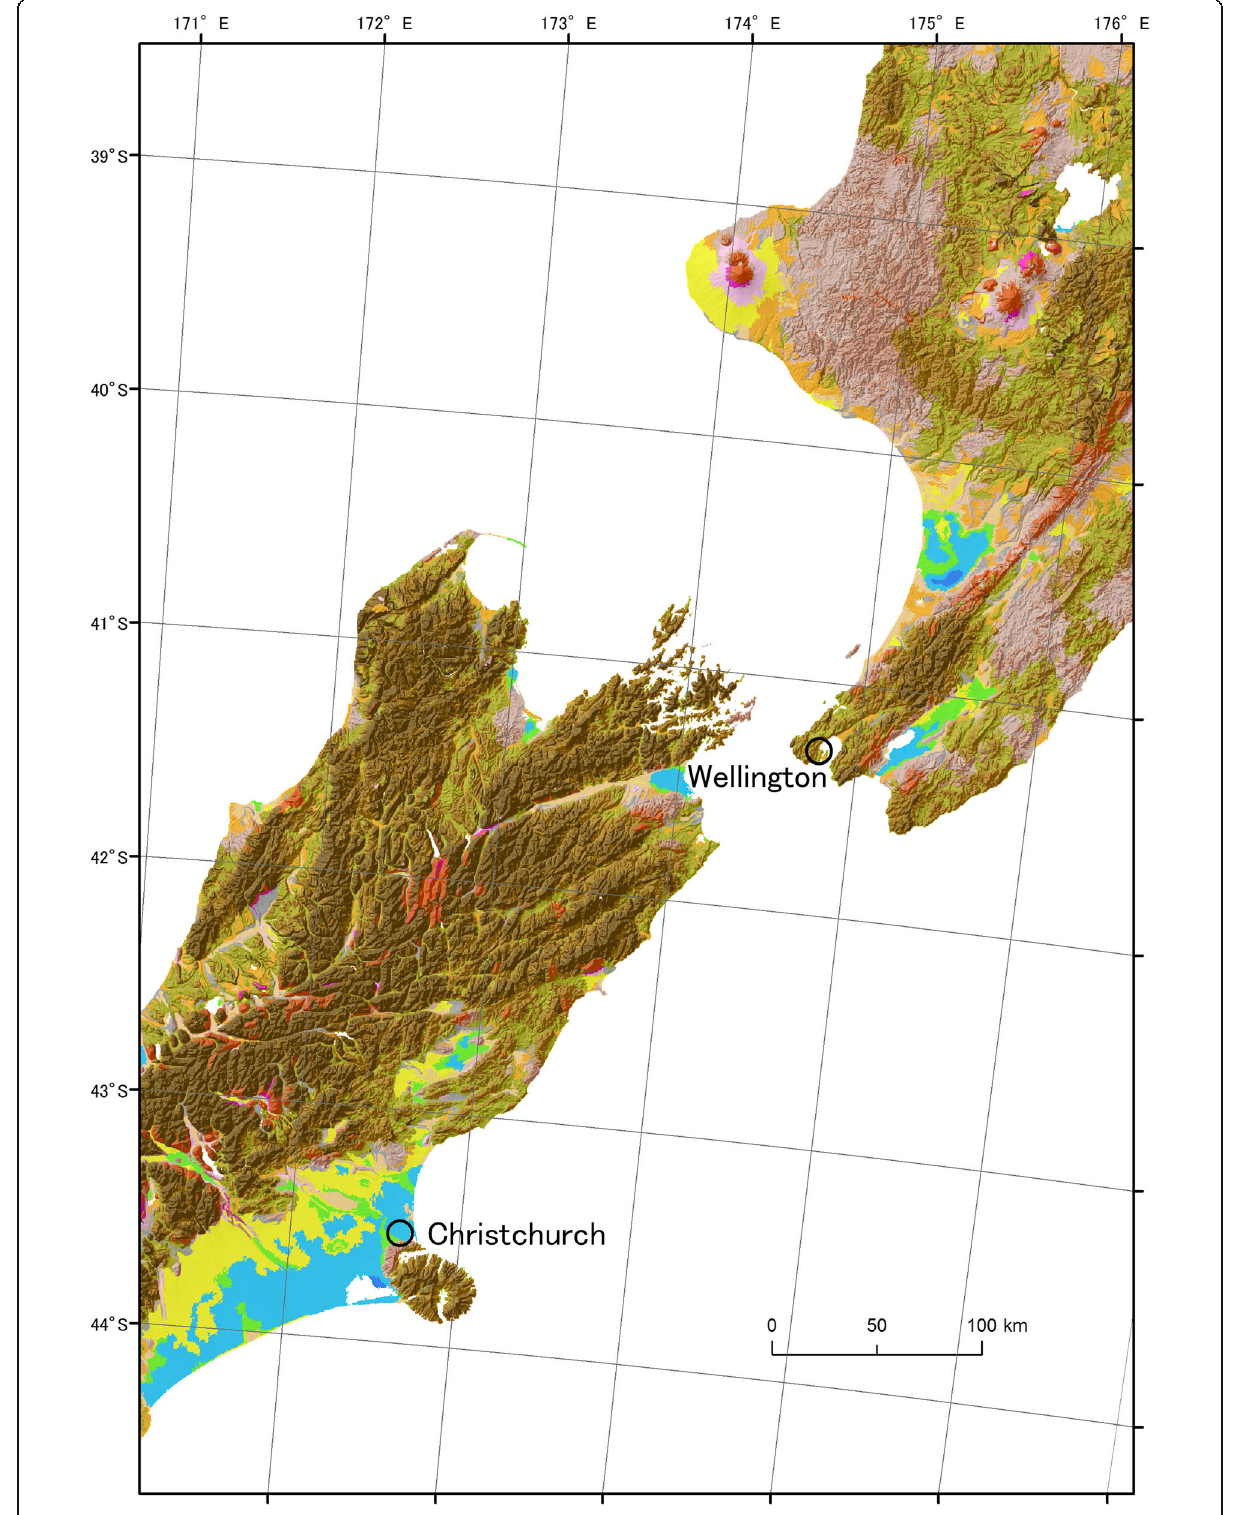
Fig. 17 Shaded terrain classification image from central New